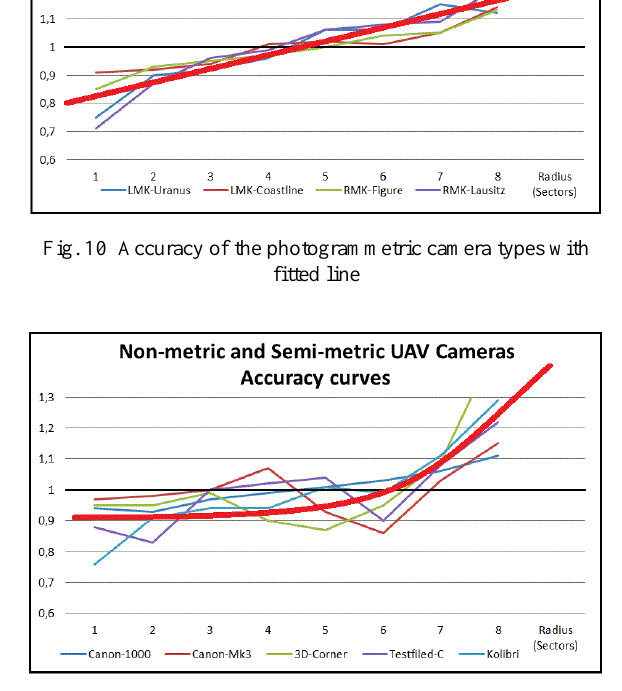
Fig. 11 Accuracy of the Non-metric and Semi-metric camera types with fitted